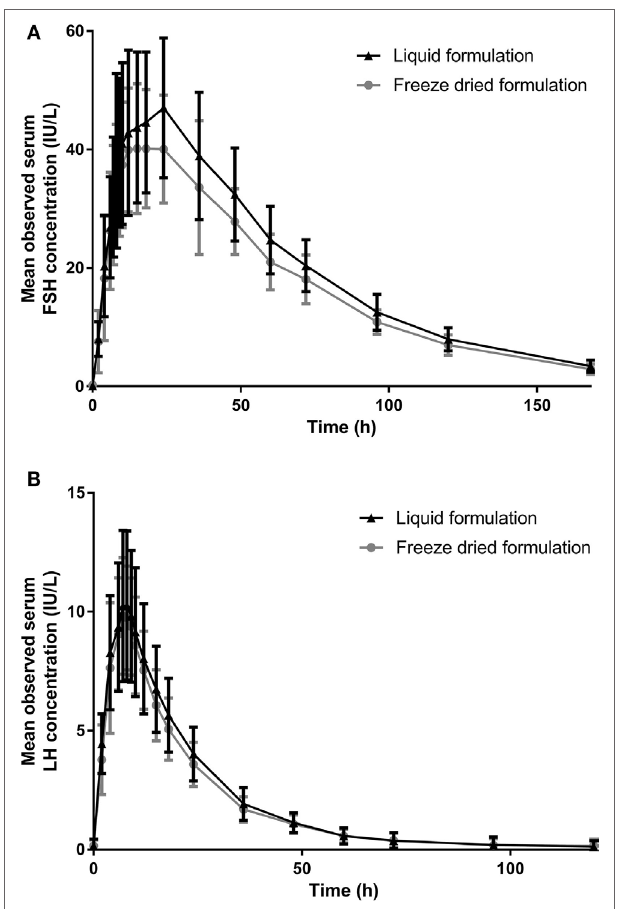
FigUrE 3 | The mean (SD) observed serum (a) FSH and (B) LH concentration over time (PK analysis set). FSH, follicle-stimulating hormone; LH, luteinizing hormone; PK, pharmacokinetic.